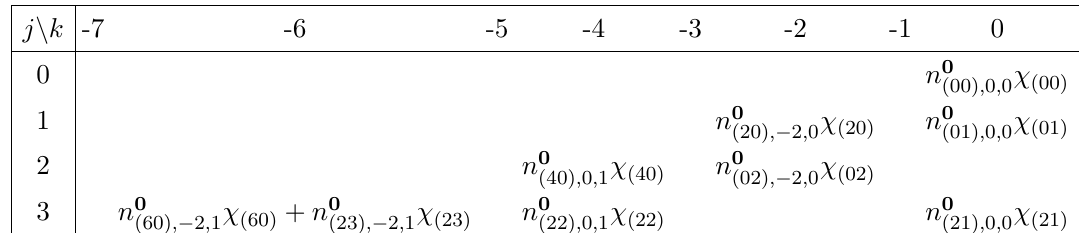
Table 14. Potential nonvanishing coe(cid:14)cients a (1) obtained from equation (5.24). The coe(cid:14)cients are written in terms of the Sp(2)